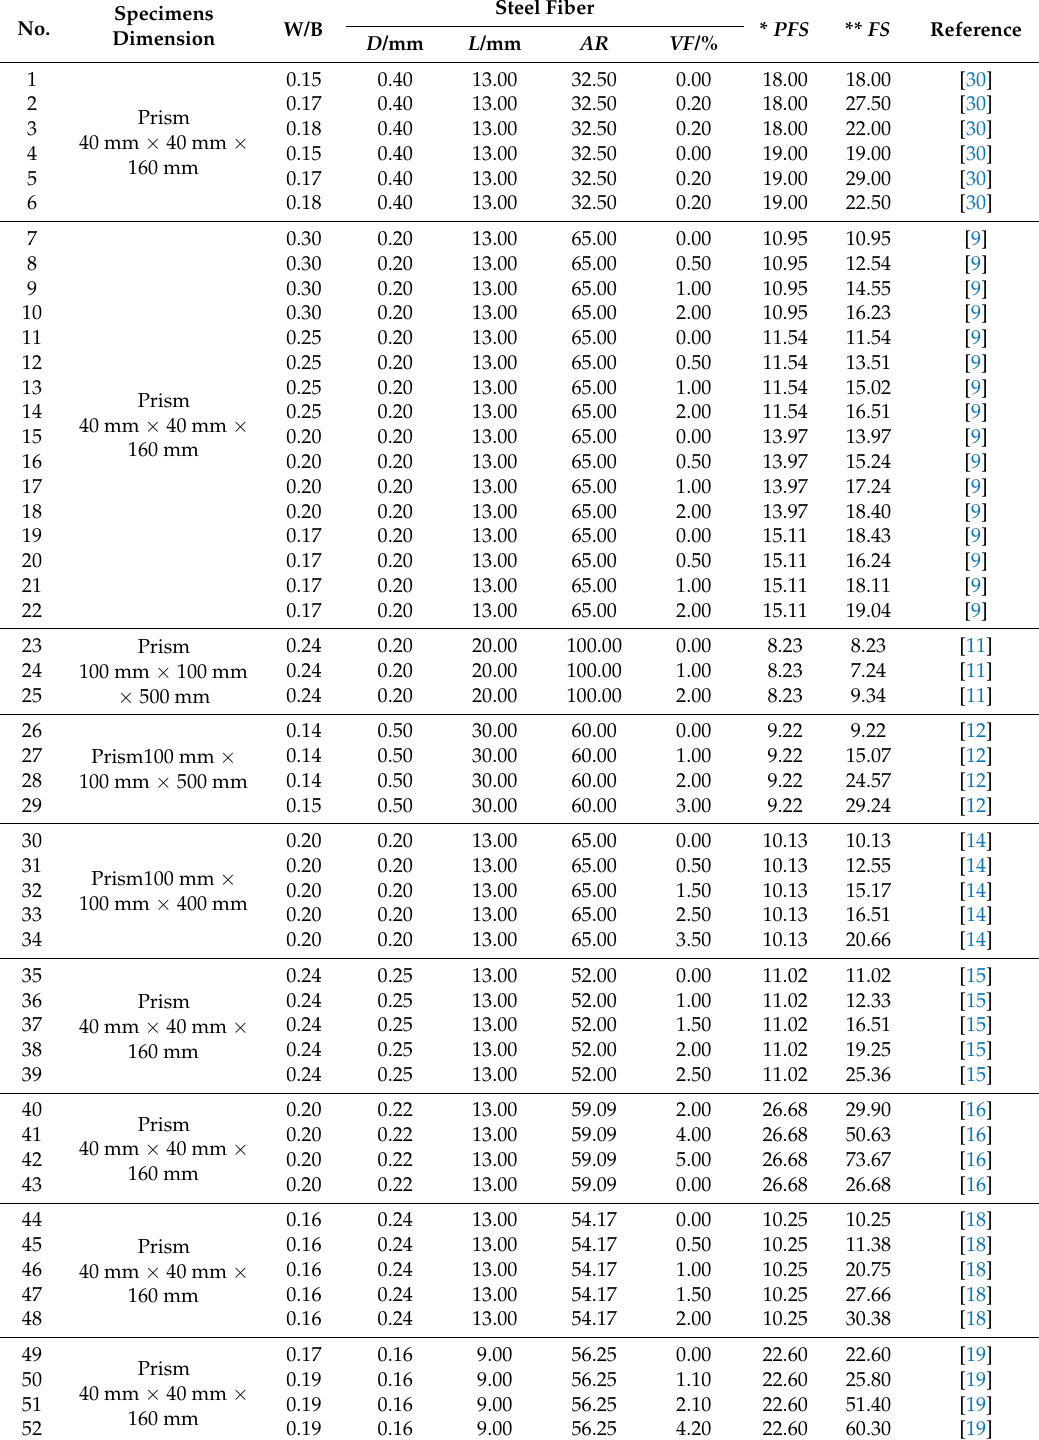
Table 2. Experimental Data used for establishing Flexural Strength ANN